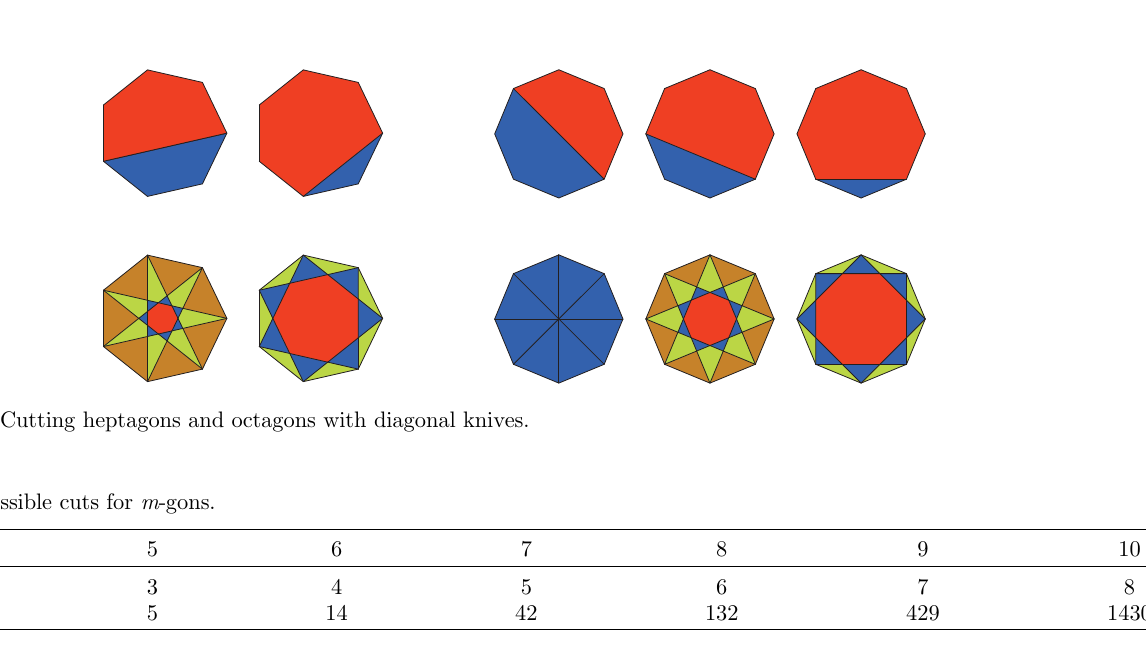
Figure 27. Fourteen ways of cutting a hexagon, with non-crossing